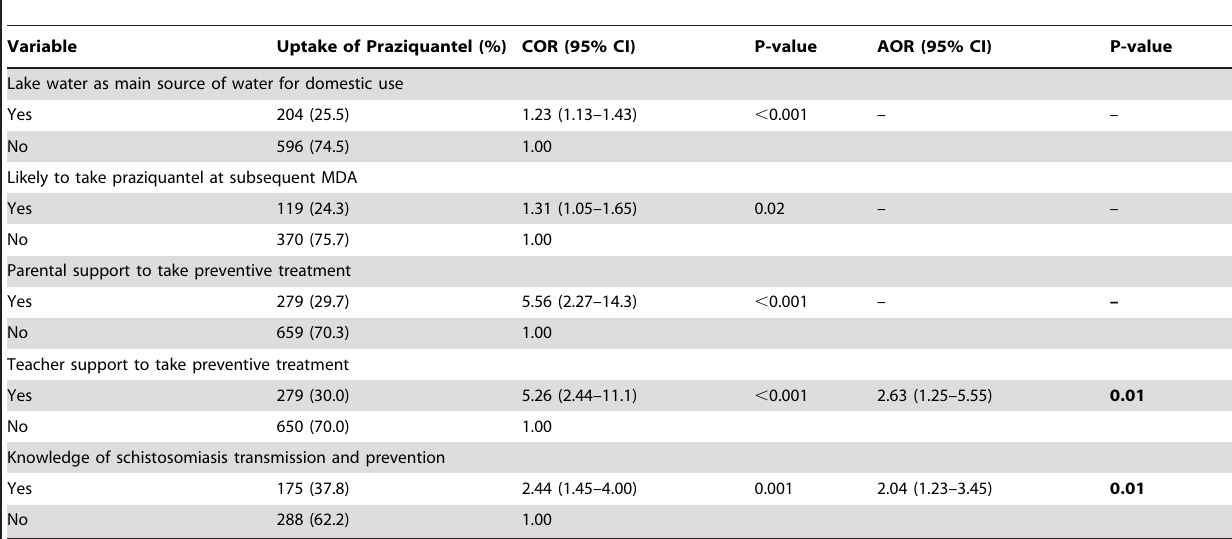
Table 2. Crude odds ratios (COR) and Adjusted odds ratio (AOR) and their 95% confidence interval (CI) for predictors of uptake of